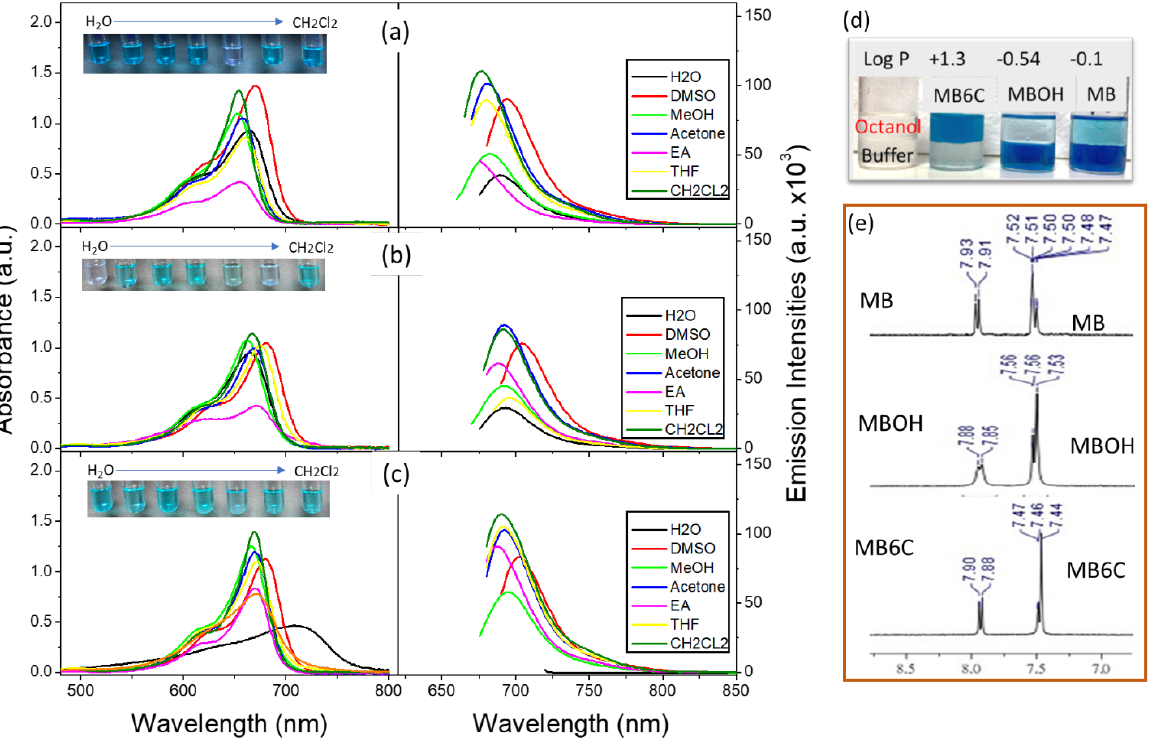
Figure 3. Absorption ( left ) and emission ( right ) spectra of 15 µM concentrations of the compounds MB ( a ), MBOH ( b ), and MB6C ( c ) in different solvents. Excitation wavelength emission spectra are depicted as absorption maxima. The partition ratios diagram of octanol/buffer solutions ( d ) and the comparison of the NMR chemical shifts (aromatic region) for these three molecules ( e ).